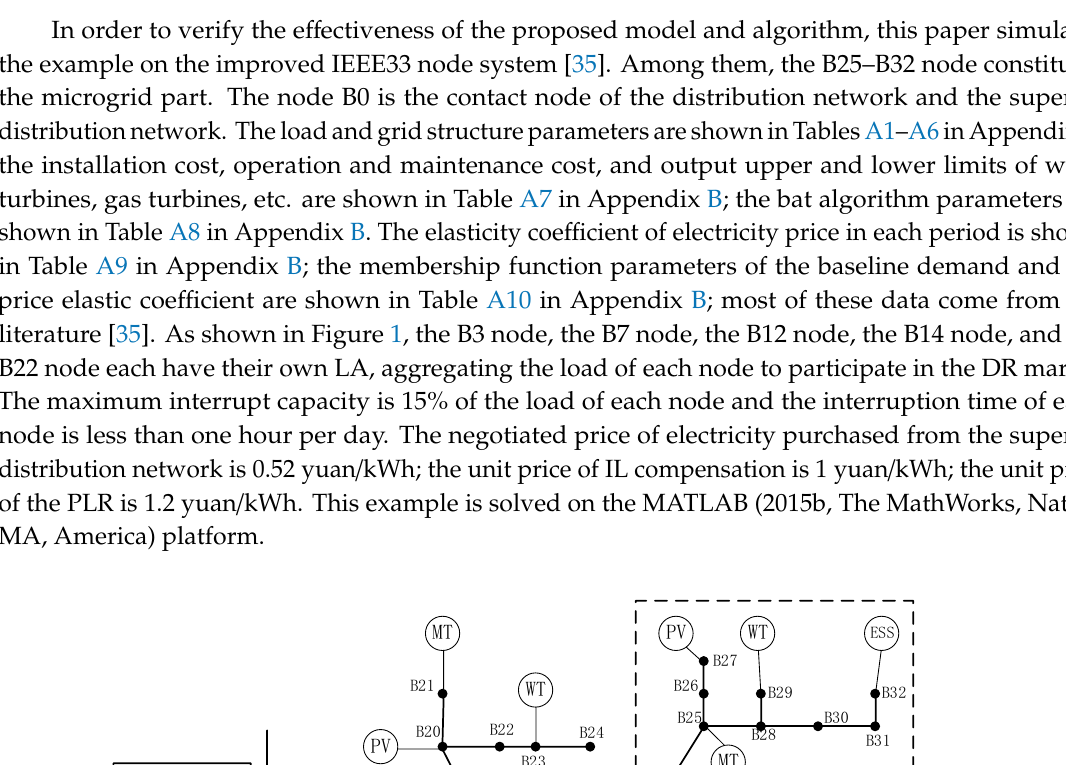
Table 1. Time-of-use price period price.